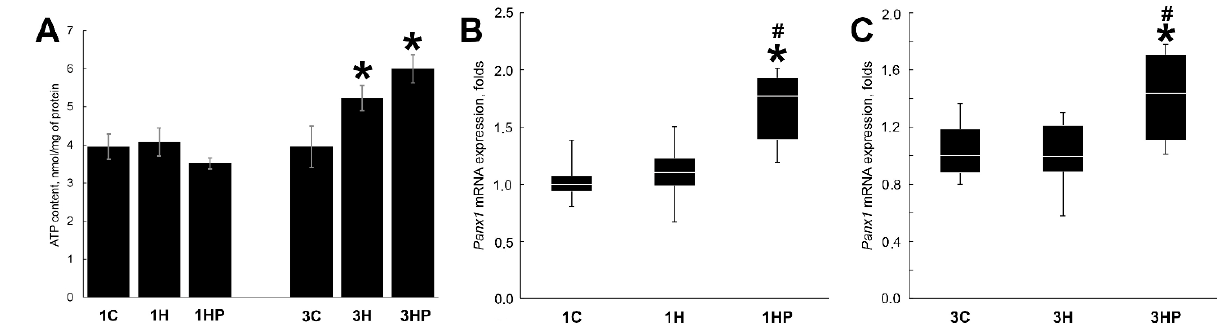
Figure 1. Evaluation of the ATP content ( A ) and Panx1 mRNA expression ( B , C ) in soleus muscles of non-treated control rats (1C and 3C), rats after 1 and 3 days of unloading (1HS and 3HS), and 1 and 3 days of HS with PRB inhibitor (1HP and 3HP). Levels of Panx1 mRNA were normalized to the levels of Gapdh in each sample ( B , C ). n = 8. * indicates a significant difference from the control, # indicates a significant difference from the HS group, p < 0.05.